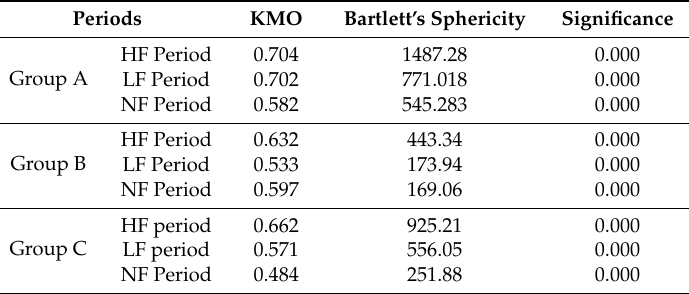
Table 4. Results for KMO and Bartlett’s sphericity test.